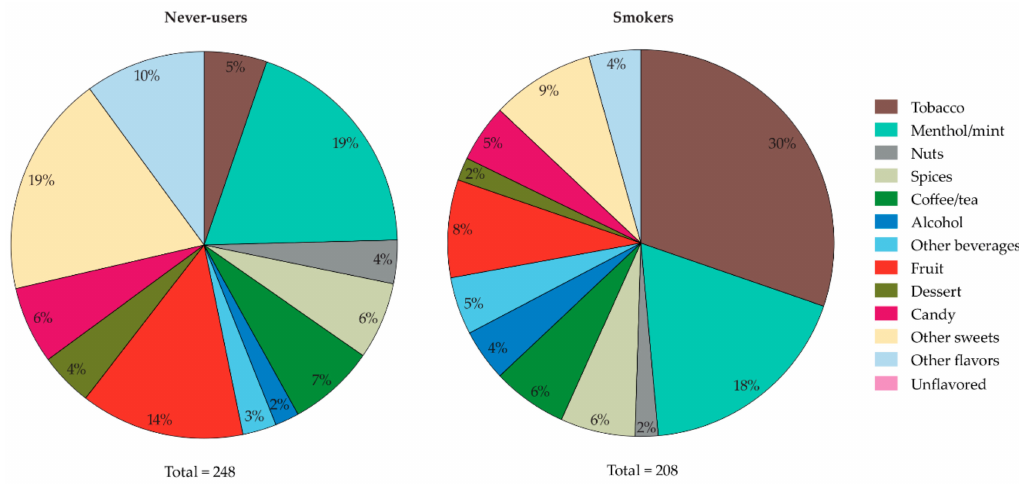
Figure 1. Interest in trying e-liquid flavors among never-users (left) and smokers (right). Never-users ( n = 278; 68%) and smokers ( n = 27; 20%) who selected the option “none of the flavors” were excluded from this visualization, and hence the pie charts visualize 248 responses from 32% of the never-users and 208 responses from 80% of the smokers. Data are presented as percentages of the total number of responses, not of the total sample